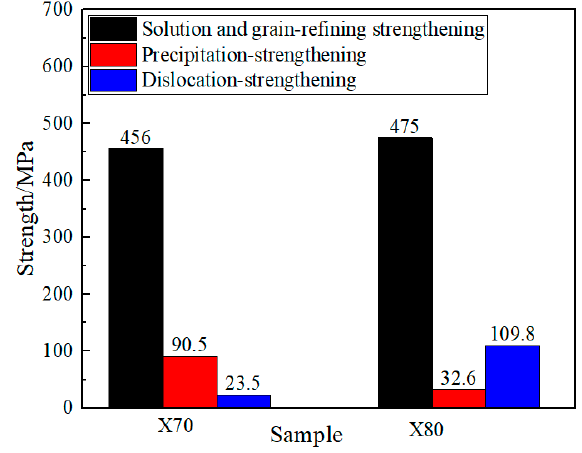
Figure 8. Strengthening contributions of X70 and X80.